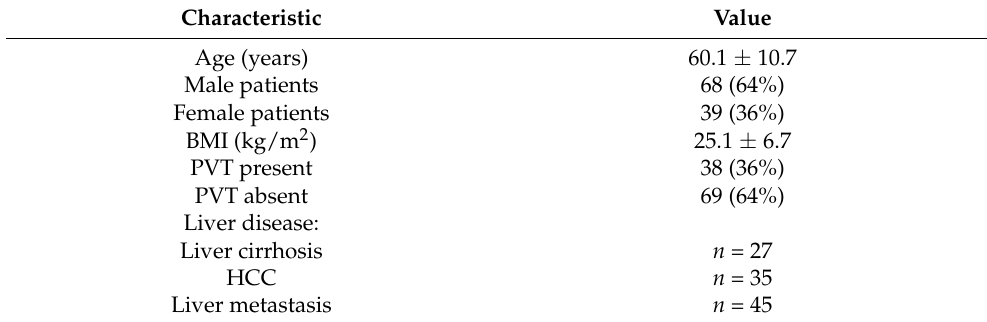
Table 1. Patient